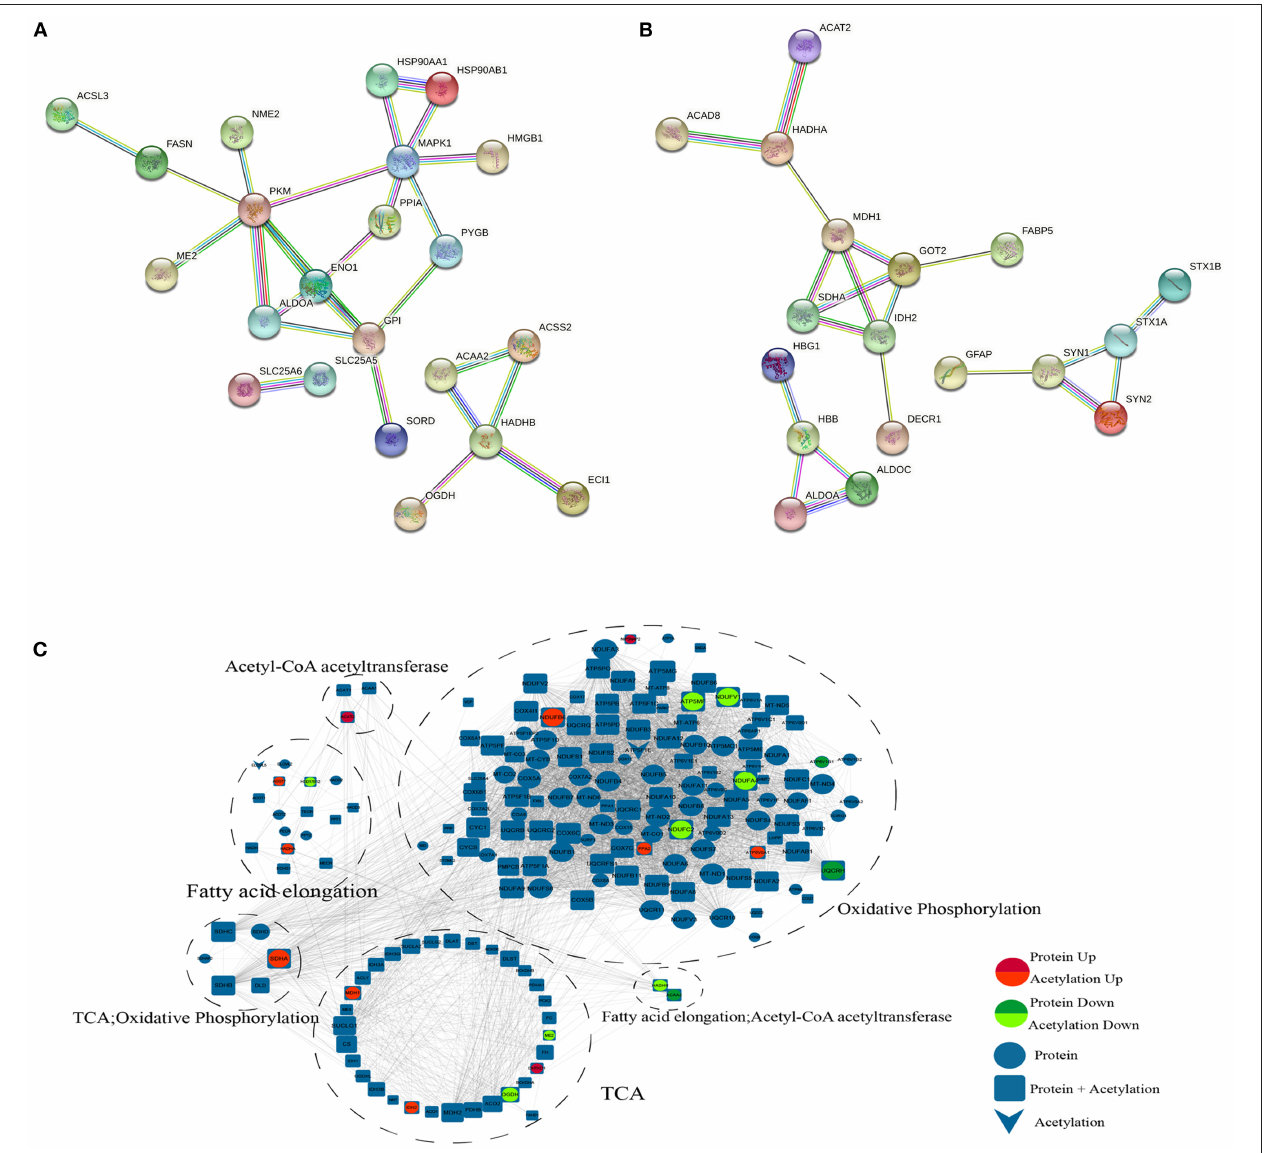
FIGURE 5 | PPI network. (A) ACAA2 and downregulated acetylated proteins (including metabolic pathways, fatty acid metabolism, and necroptosis). (B) ACAT2 and upregulated acetylated proteins. (C) ACAA2, ACAT2, and metabolic pathway (including oxidative phosphorylation, fatty acid elongation, and TCA cycle). mitochondrial pathways were regulated by protein